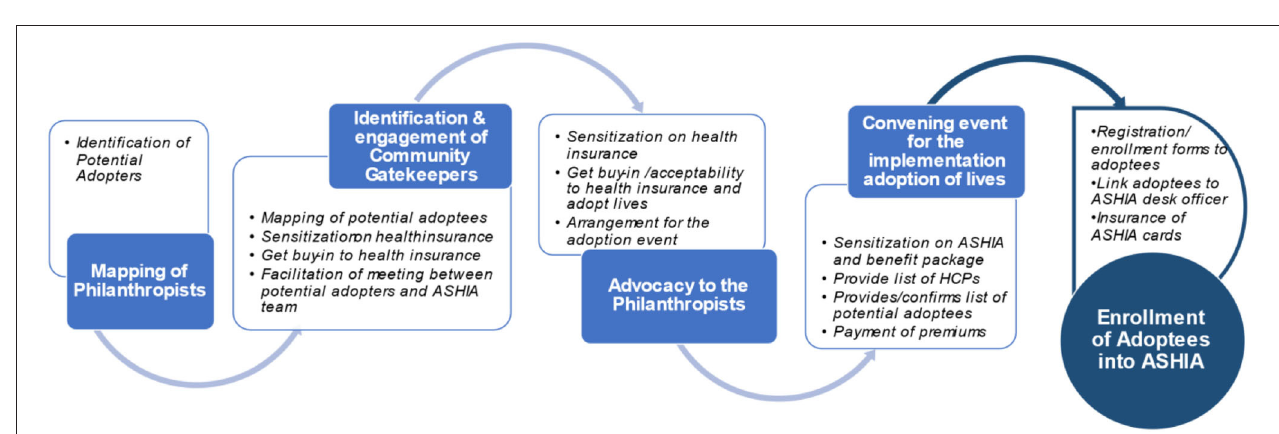
FIGURE 2 | Summary of the chronological description of process of adoption model of health